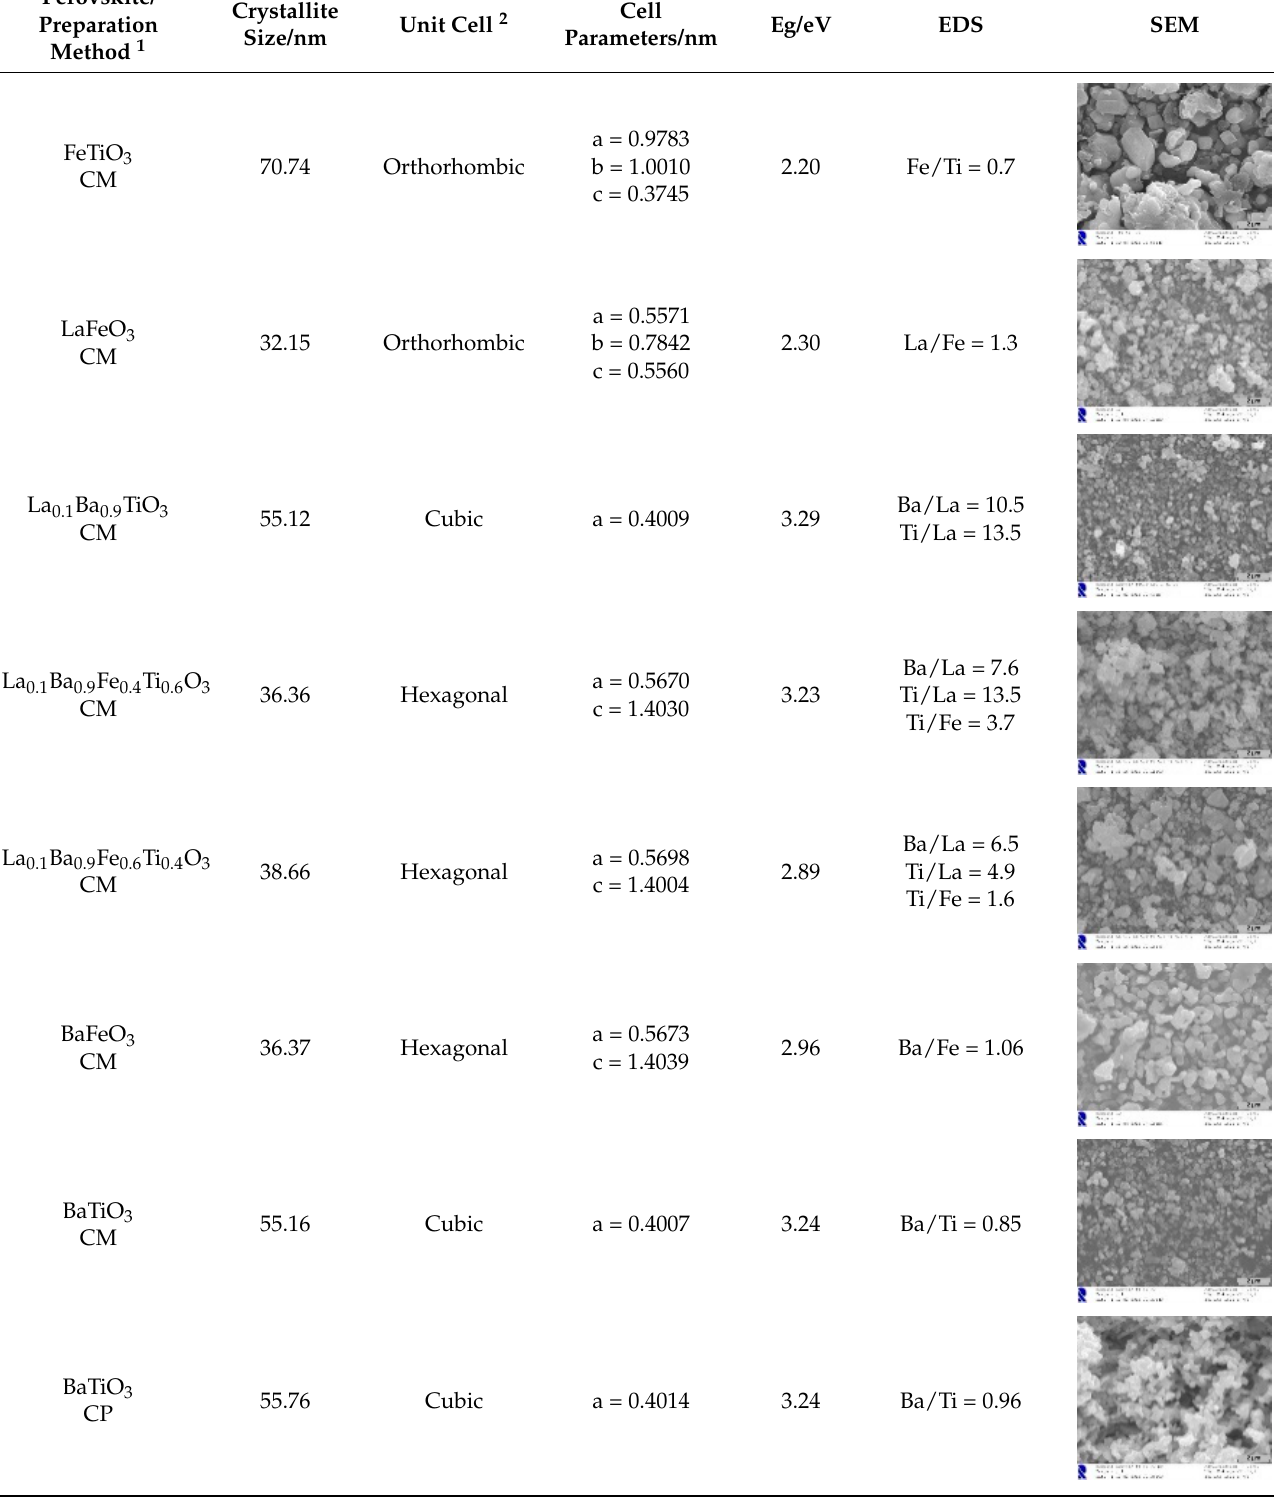
Table 1. Physical properties of perovskite powders and FeTiO 3 prepared by different experimental conditions. Perovskite/